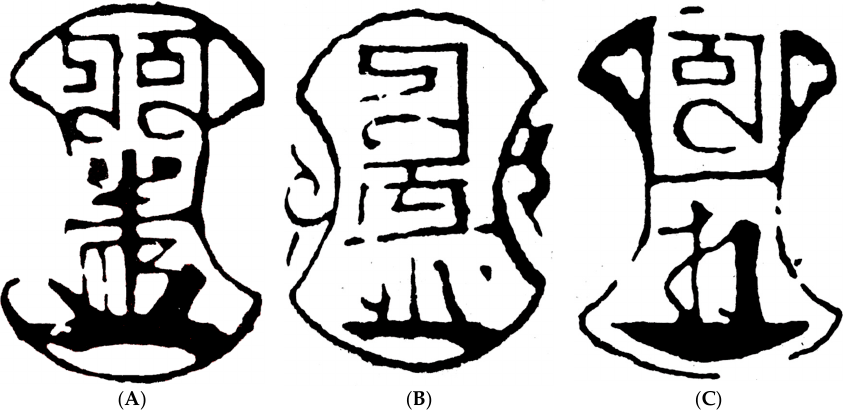
Figure 34. ( A ) A Song Yuan Huaya carved with Phagspa characters and an ethnic character. The Yuan dynasty. Sketched by author. Picture source: Shi (1995), p. 52. ( B , C ) The Song Yuan Huaya carved with Phagspa character(s) and an ethnic character. The Yuan Dynasty. Inventory number: 1852 and 1853. Sketched by author. Picture source: Wen (1995), p.